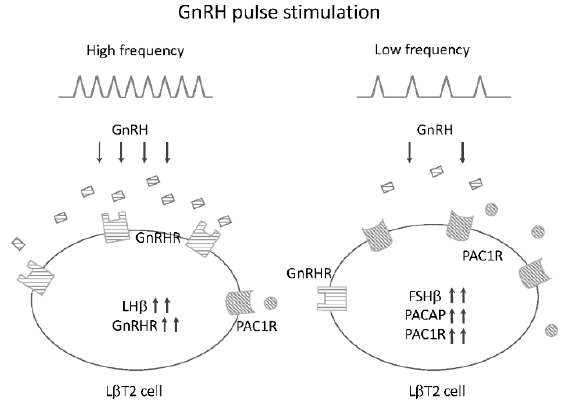
Figure 3. Schematic summary of the changes in pituitary gonadotrophic L β T2 cells by high- and low-frequency pulsatile GnRH stimulation. High-frequency GnRH pulse stimulation preferentially stimulates LH β -subunit and GnRH receptor expression. On the other hand, FSH β -subunit, PACAP, and PAC1R gene expression predominantly occurs under low-frequency GnRH pulses.